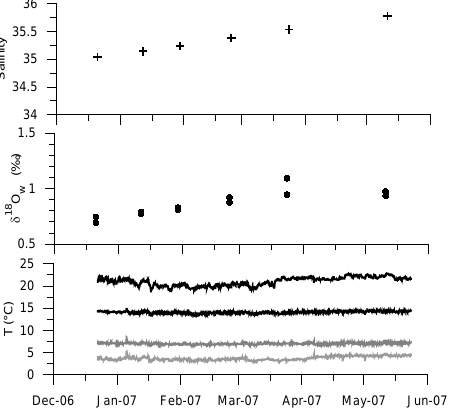
Fig. 2. Salinity, δ 18 O w , and temperature measured during the ex- periment. Two water samples from the reservoir tank were taken for salinity and δ 18 Ow at each sampling occasion, temperature was measured continuously with data loggers.